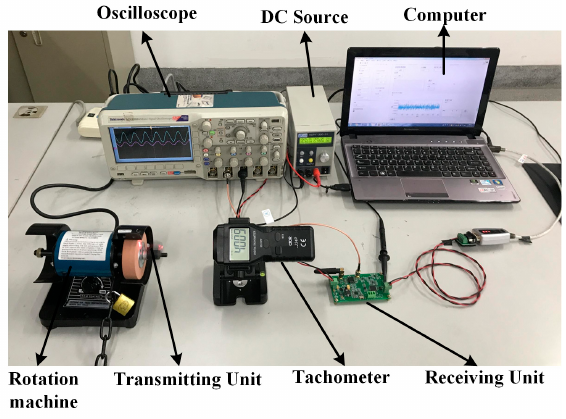
Figure 5. The gyroscopic effect verification platform.